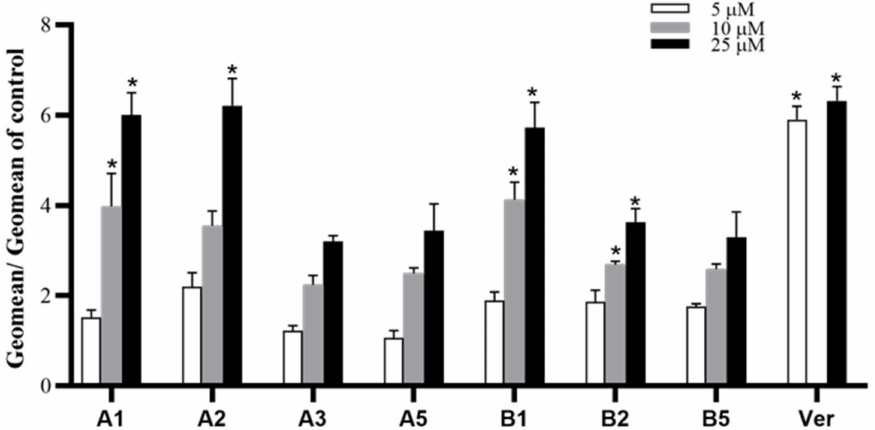
Figure 1. Flow cytometric detection of Rhodamine123 e ffl ux in MES-SA-DX5 drug resistant cells. Cells were suspended in RPMI 1640 and treated with synthesized derivatives A1 , A2 , B1 , and B2 . After incubation for 20 min, 5 µ M Rh123 was added and the cells incubated for another 20 min at 37 ◦ C. Afterwards, the cells were centrifuged and washed twice with ice-cold PBS and resuspended in PBS. The fluorescence signal caused by the presence of Rh123 inside the cells was measured using a flow cytometer with excitation and emission wavelengths of 488 nm and 530 nm, respectively. Representative histograms of cells treated with di ff erent concentrations of test compounds are shown.